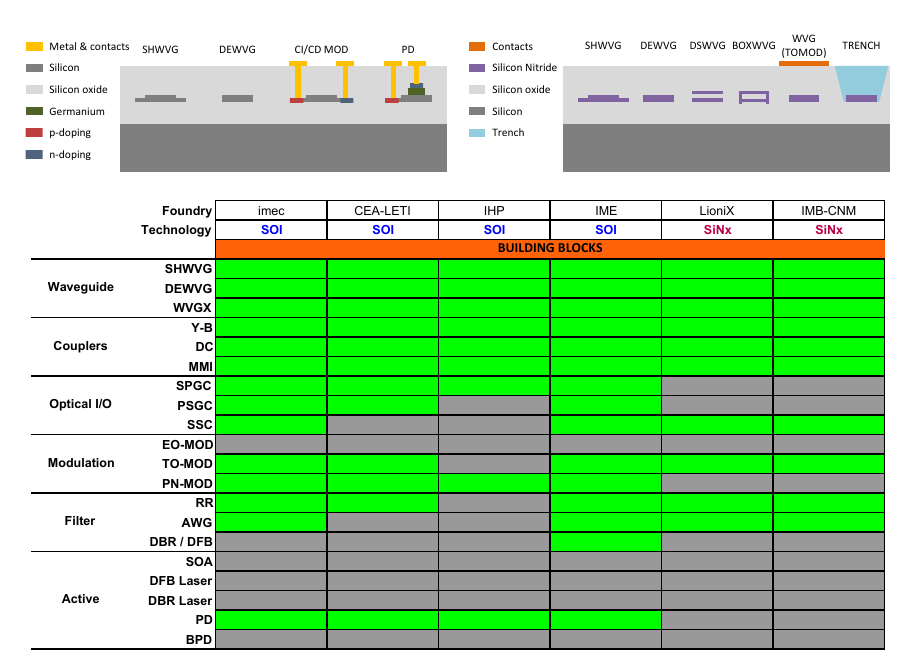
Figure 1. Applications versus wavelength range, and the different material systems, III–V semiconductor and Silicon photonics, commonly employed in generic photonic integration (Reference [3], adapted with permission from OSA Publishing).